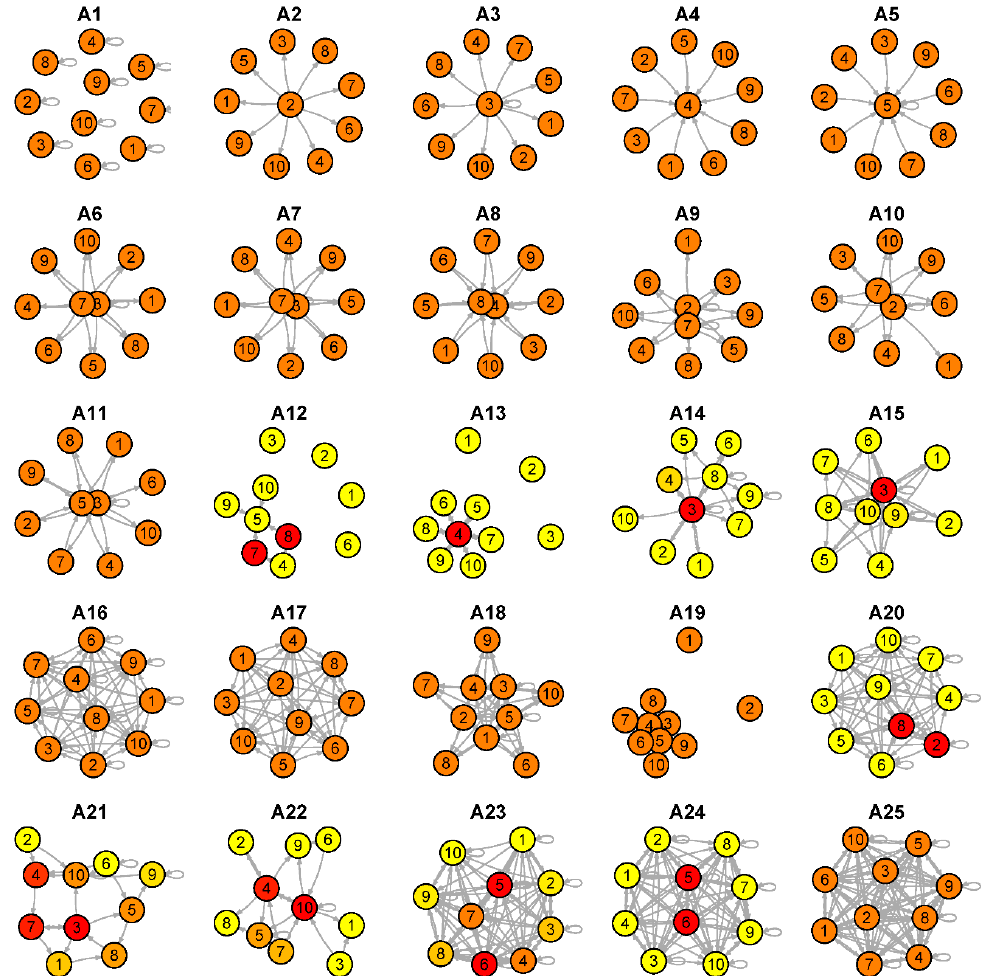
Figure A4. Graphs G ( i ) with betweenness centralities colored by the yellow-red Figure 4. Graphs G ((cid:3036)) with betweenness centralities colored by the yellow-red gradient.